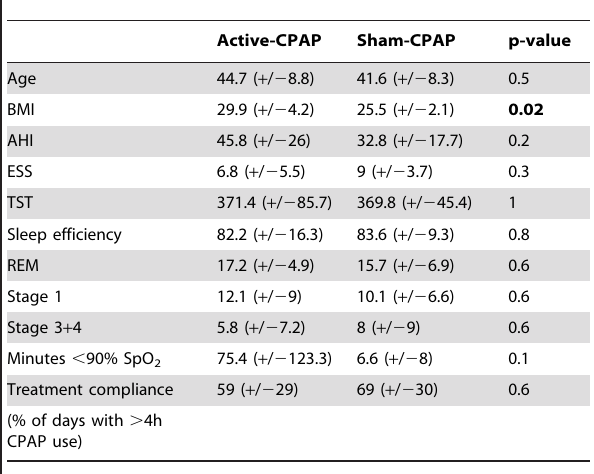
Table 1. Sample characteristics.